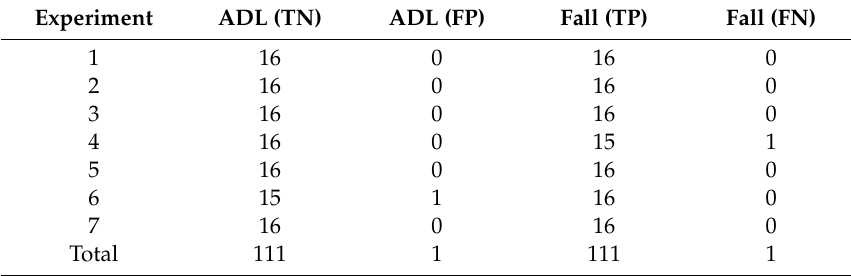
Table 2. Patient activities, including seven types of fall and seven types of